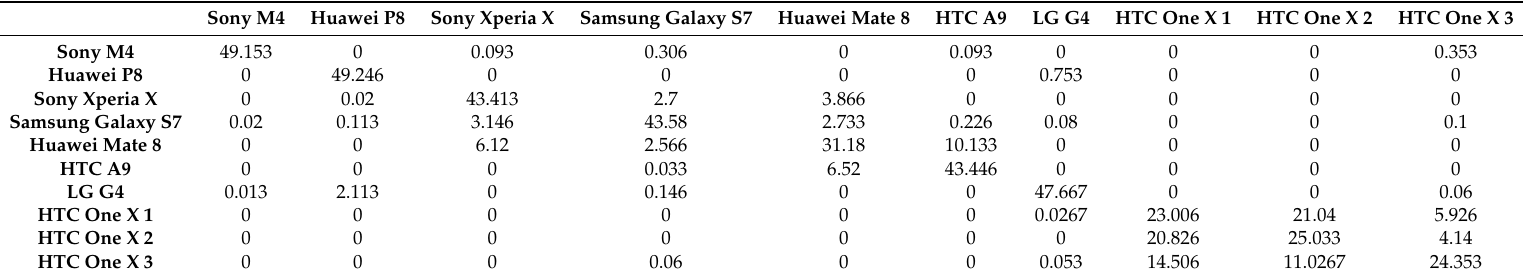
Table 4. Confusion matrix based on SVM and optimal values for the digital output generated by the magnetometer on the Y axis. Values have been averaged over the 50